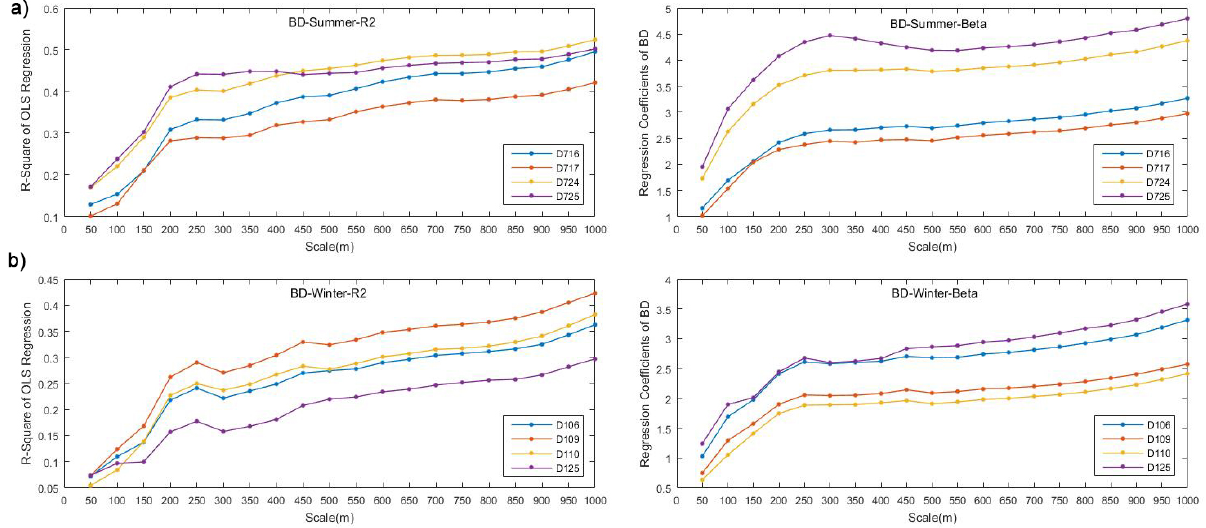
Fig 3. Scalograms showing the scaling effects on BD-AT relationships: a) the R 2 and the coefficients of the bivariate model between BD and AT in summer; b) the R 2 and the coefficients of the bivariate model between BD and AT in